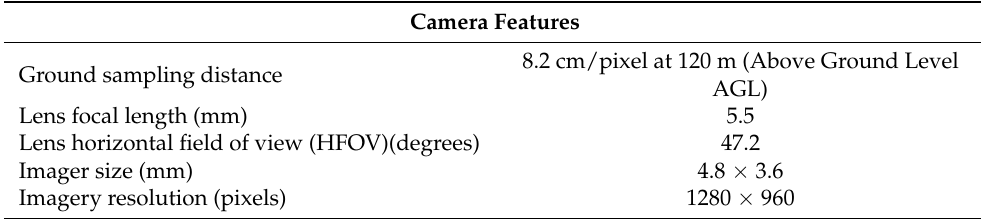
Table 4. MicaSense RedEdge multispectral camera specifications (courtesy of www.micasense.com, accessed on 8 July 2022).